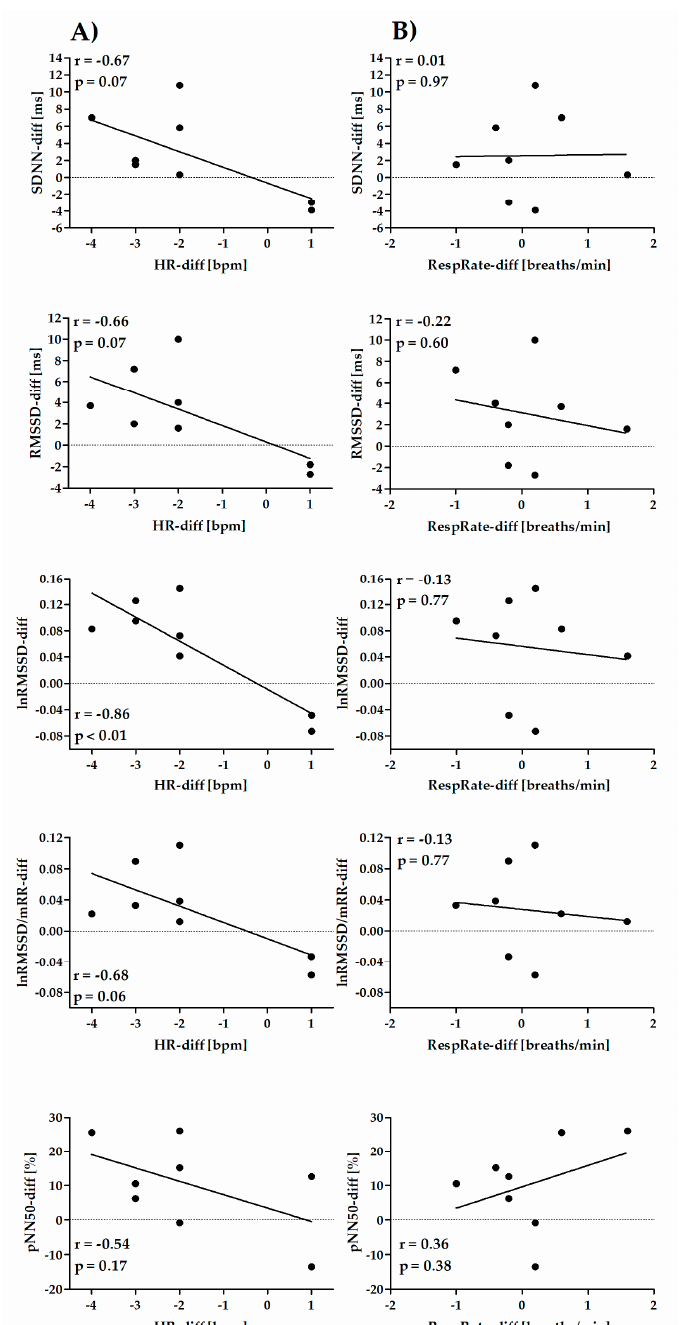
Figure 4. Pearson (cid:48) s correlation coe ffi cient between Retest–Test di ff erences in time-domain short-term Figure 4. Pearson ′ s correlation coefficient between Retest–Test differences in time-domain short-term (5 min) HRV parameters and di ff erences in HR (HR-di ff ) (column A ) or RespRate (RespRate-di ff ) (5 min) HRV parameters and differences in HR (HR-diff) (column A ) or RespRate (RespRate-diff) (column B (column B ).